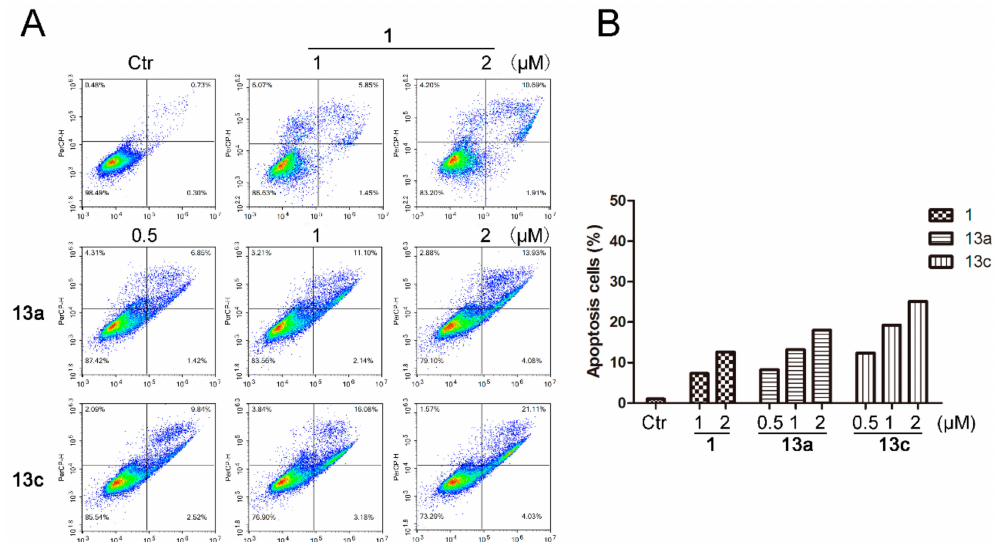
Figure 7. The e ff ects of compounds 13a and 13c on cell apoptotic progression in MDA-MB-231 cells. ( A ) MDA-MB-231 cells were treated with SAHA or di ff erent doses of 13a and 13c and stained with AAD, followed by flow cytometry analysis. ( B ) Quantitative